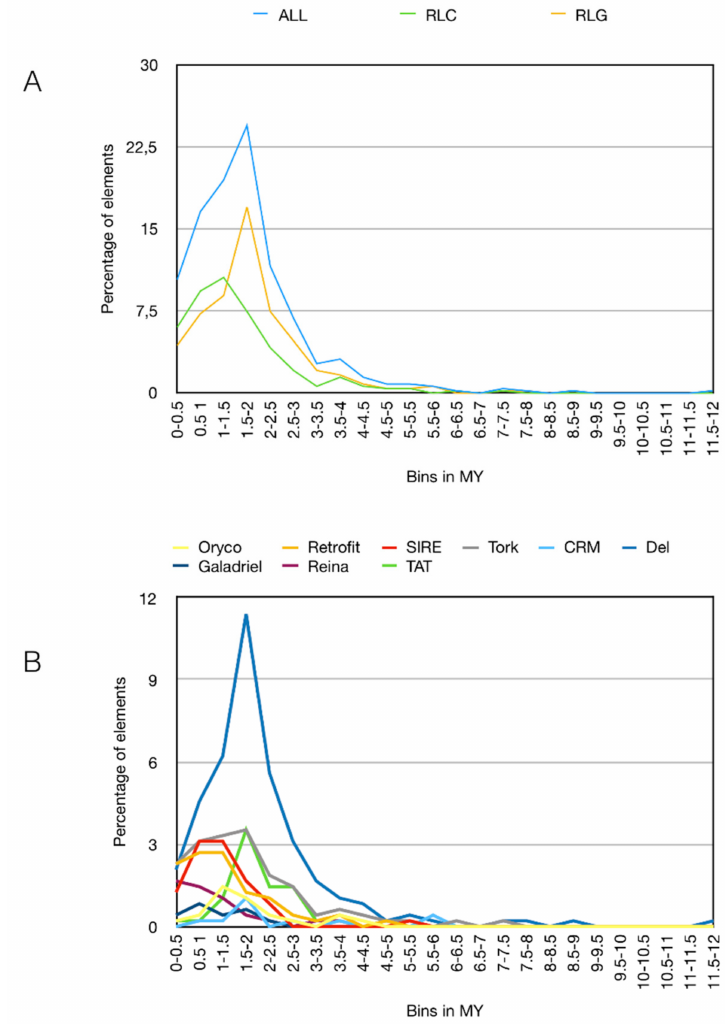
Figure 7. Timing of full-length LTR retrotransposon insertions. ( A ) Blue, yellow and green lines represent respectively the percentage of Gypsy and Copia full-length LTR retrotransposons per bins of 0.5 Million Years (MY); ( B ) colored lines represent the percentage of full-length LTR retrotransposon lineages per bins of 0.5 MY. Only the full-length LTR retrotransposons found by LTR_STRUC were used here. An average base substitution rate of 1.3 × 10 − 8 was used as the default